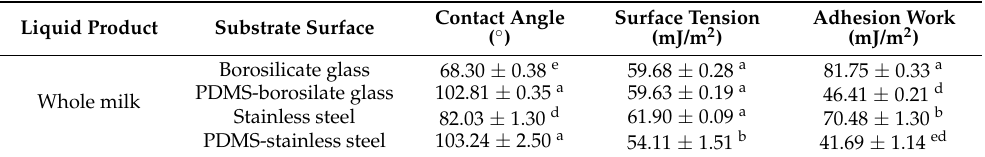
Table 7. The contact angle, surface tension, and adhesion work of whole milk products analysed on the native and PDMS-treated borosilicate glass and stainless steel substrates. Different letters in the same column show significant differences ( p < 0.05).